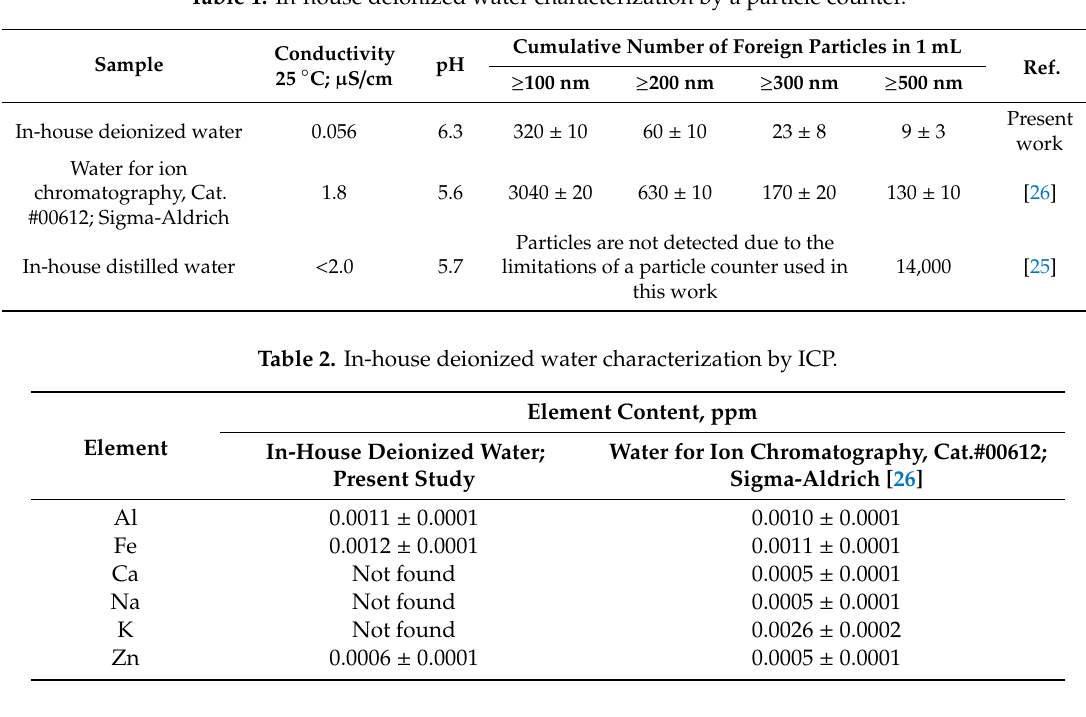
Table 1. In-house deionized water characterization by a particle counter.